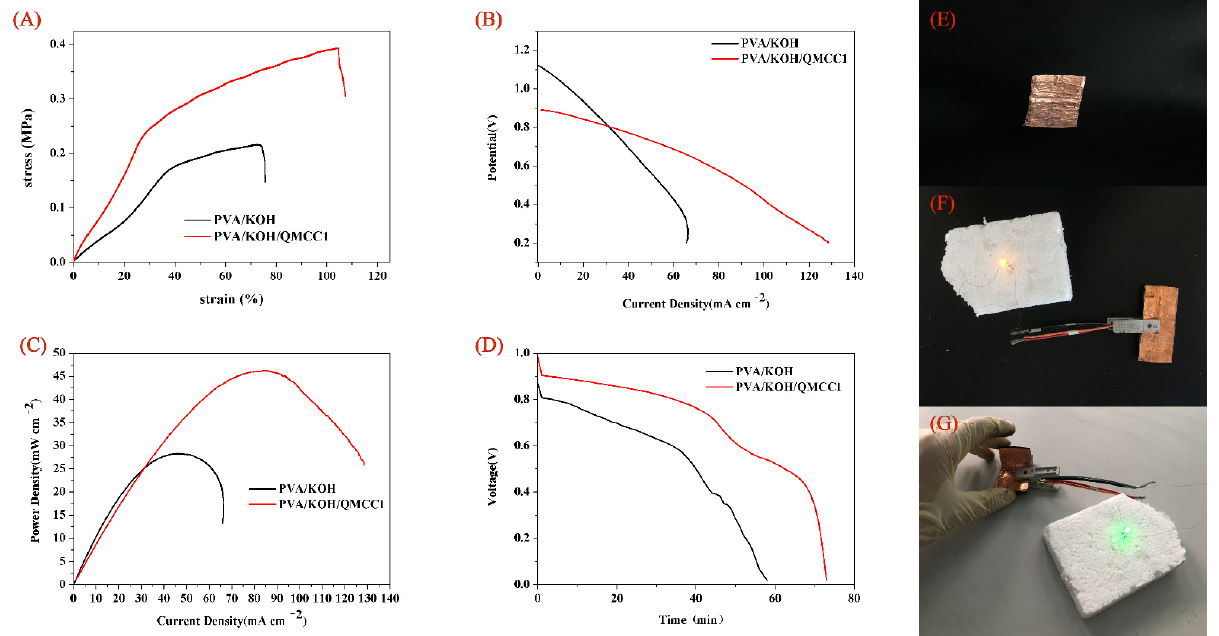
Figure 8. ( A ) The stress–strain curves of PVA/KOH and PVA/KOH/QMCC1. ( B ) Polarization curves of Zn–air battery using PVA/KOH and PVA/KOH/QMCC1 as the alkaline solid polyelectrolyte (ASPE) membrane. ( C ) Power density curves of Zn–air battery using PVA/KOH and PVA/KOH/QMCC1 as the ASPE membrane. ( D ) Discharge curve of Zn–air battery with a current density of 20 mA cm − 2 using PVA/KOH and PVA/KOH/QMCC1 as the ASPE membrane. ( E ) Assembled Zn–air battery. ( F ) and ( G ) Application of Zn–air battery in LED bulb.